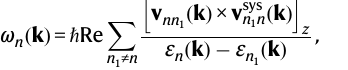
composition l z n ð k Þ , and the brown curve shows the pro fi le of central peaks of σ sys H . White curves in b , c show energy contours at 1/2 and 3/4 of the band width. Black dashed hexagons in b , c denote the boundary of moiré Brillouin